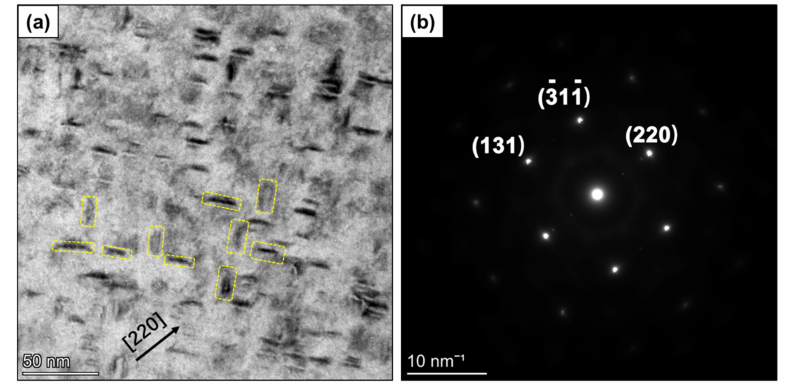
Figure 4. The TEM image of the nanoscale precipitations in 945A-32h sample, ( a ) the bright field TEM image of the precipitates, ( b ) the selected area diffraction